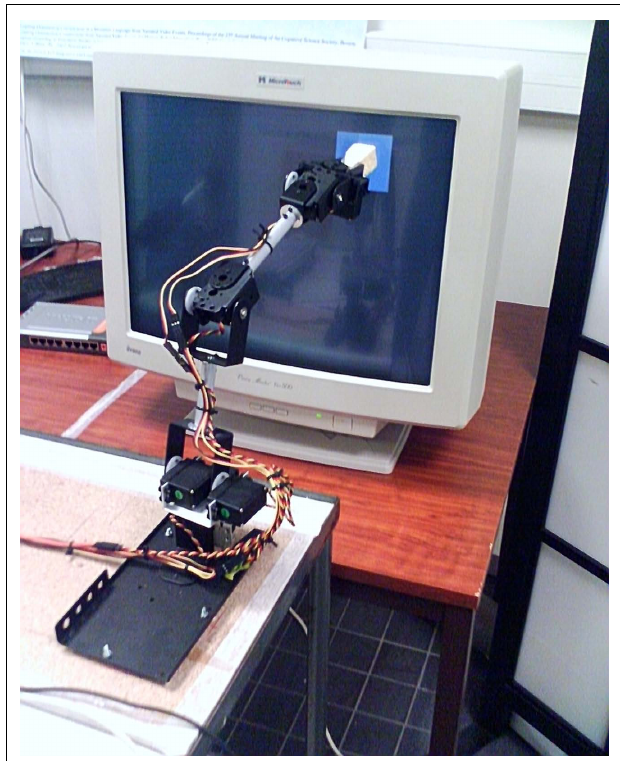
FIGURE 1 | Lynxmotion SES robotic arm in front of a touch screen used for Experiment 1. The screen is perceived by a webcam.The arm has a gripper with a sponge surrounded by aluminum connected to the ground. This produces a static current when contacting the screen and enables the screen to detect when and where the robot touches it.This setup allows us to test the robot in the same experimental conditions as the non-human primate subjects in our previous studies (Amiez et al., 2006; Quilodran et al., 2008).